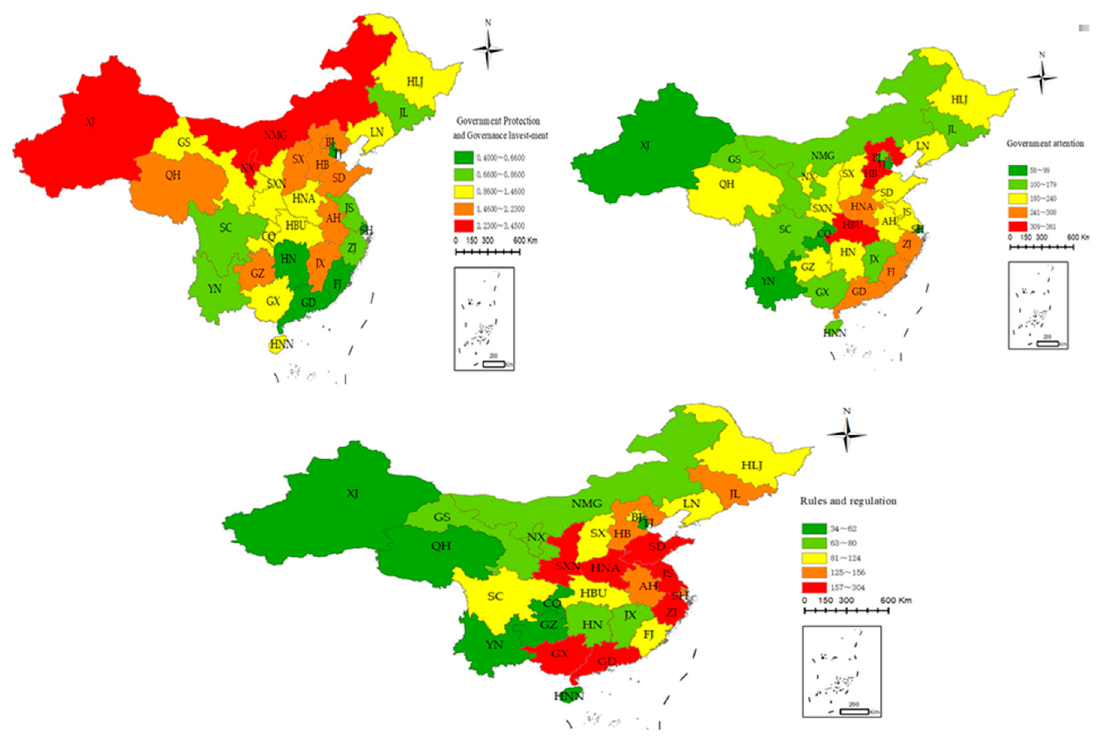
Figure 2. The spatial distribution of ER. Note: The upper left, upper right, and bottom graphs reflect the spatial distributions of government investment in environmental protection, government attention, and rules and regulations, respectively.